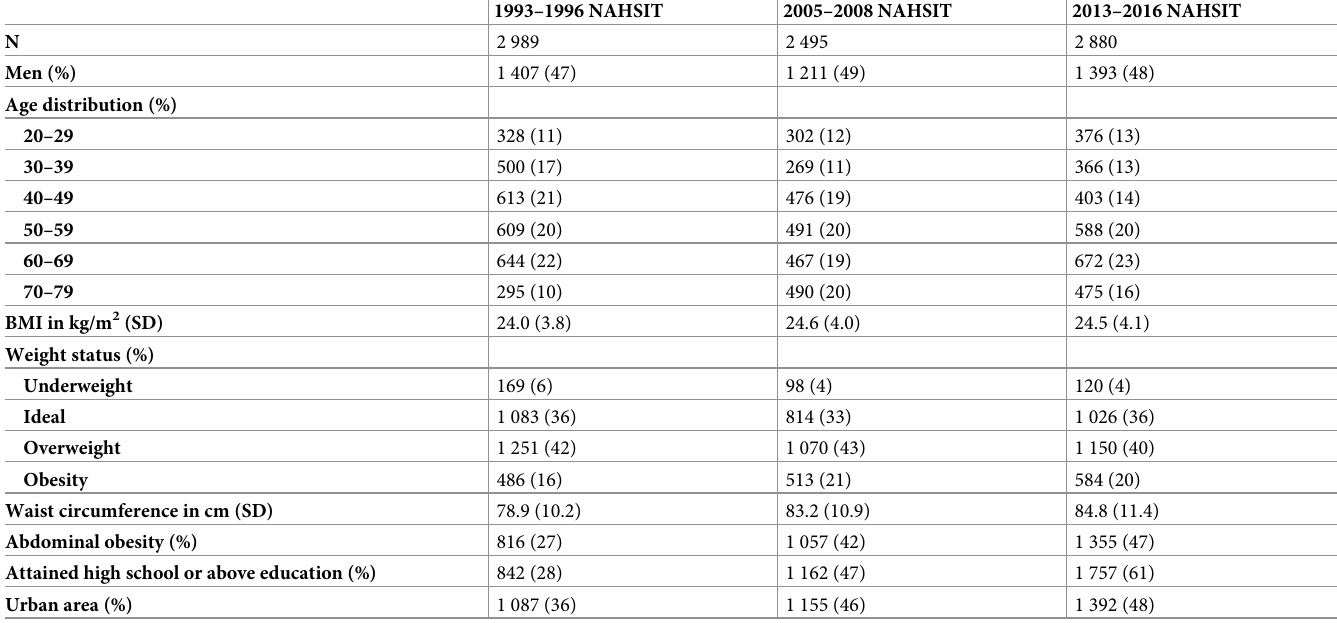
Table 1. Characteristics of the